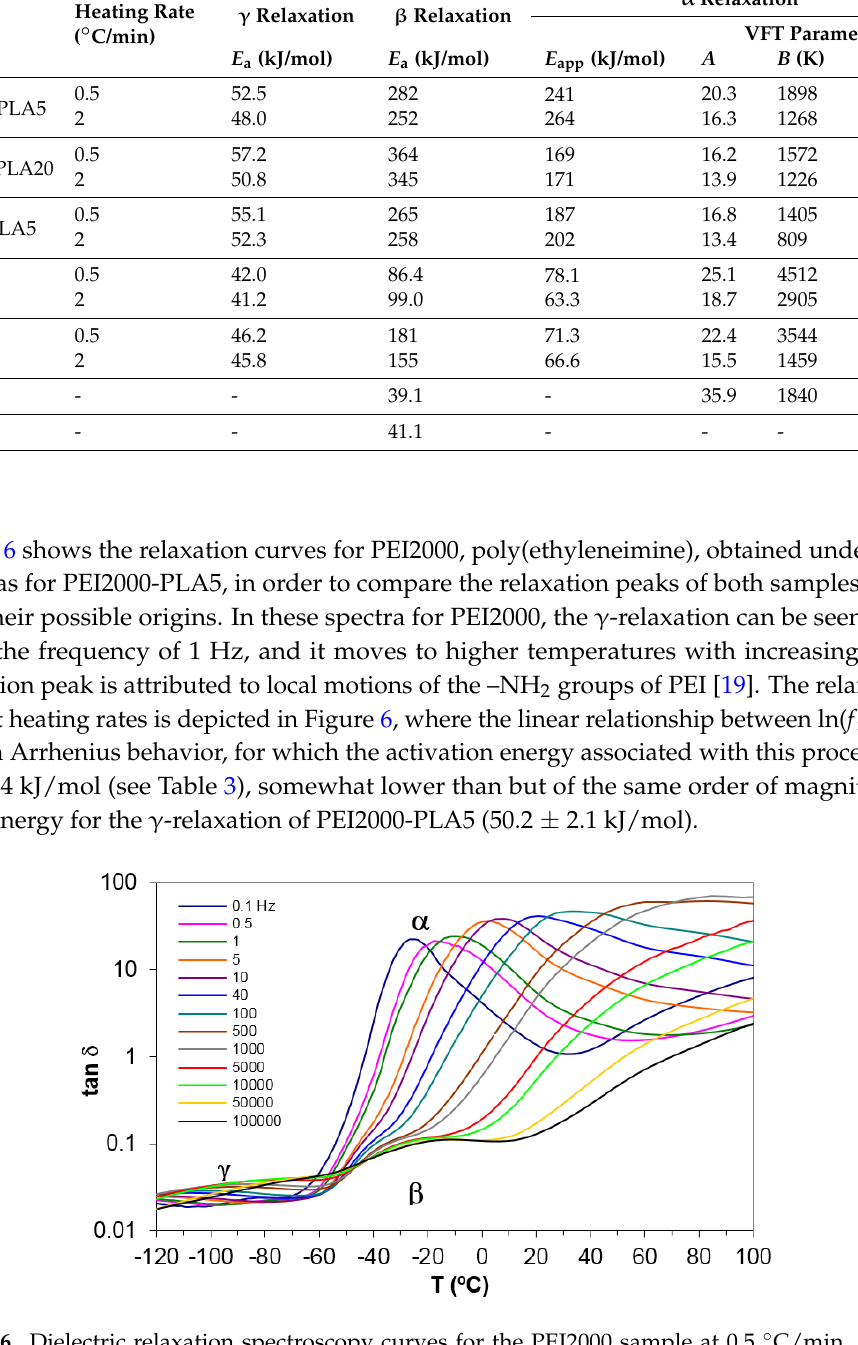
Figure 6. Dielectric relaxation spectroscopy curves for the PEI2000 sample at 0.5 °C/min, for the frequency range from 0.1 Hz to 100 kHz.